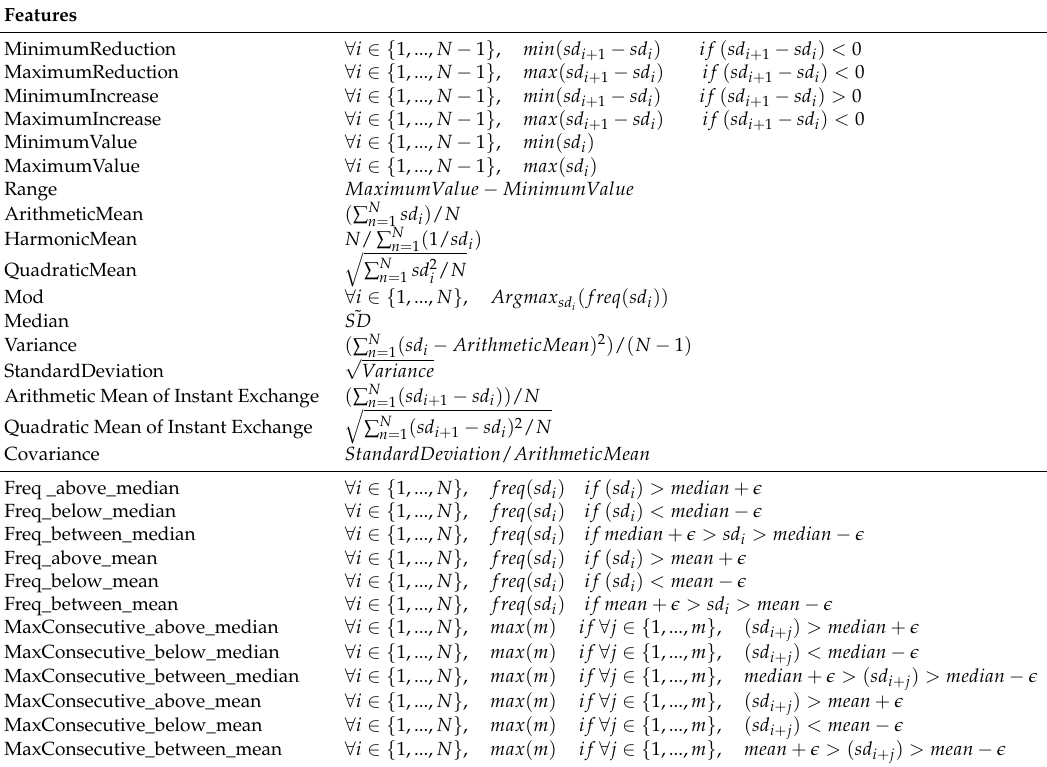
Table 2. Feature